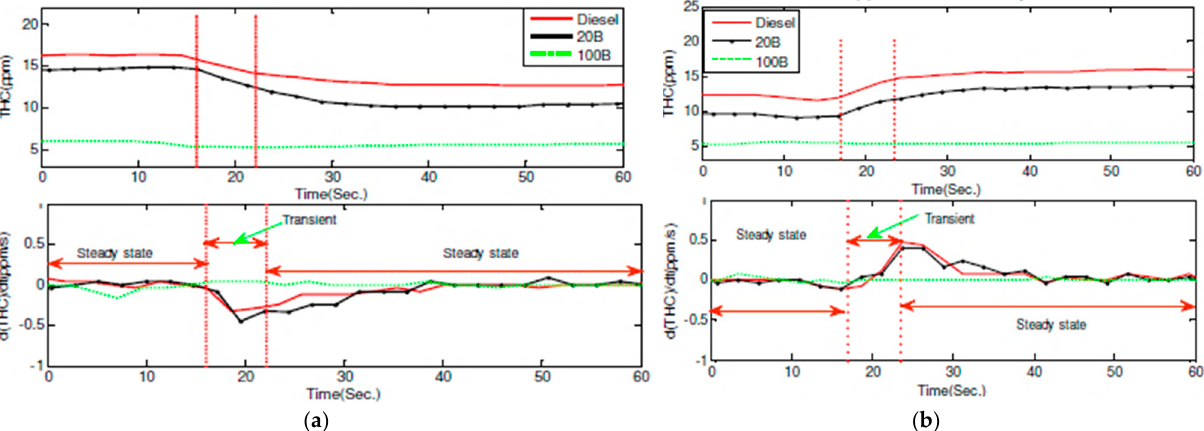
Figure 19. ( a ) Top: Time variation of THC emission with the three fuels during positive torque at 1500 rpm; bottom: Attendant rate of change of THC emission ( b ) Top: THC emission in the CI engine running with biodiesel, 2B and 100B fuels during negative torque transient at 1500 rpm; bottom: Corresponding rate of change of THC emissions.